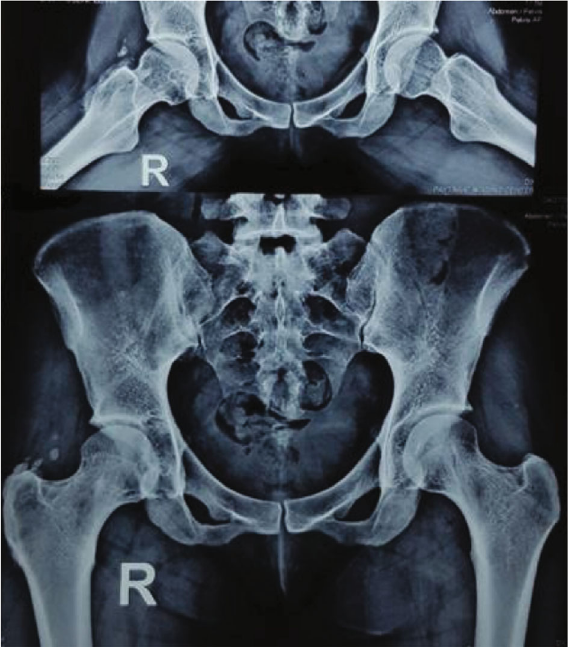
Figure 6: Latest postoperative follow-up X-ray supporting disease- free condition of the right